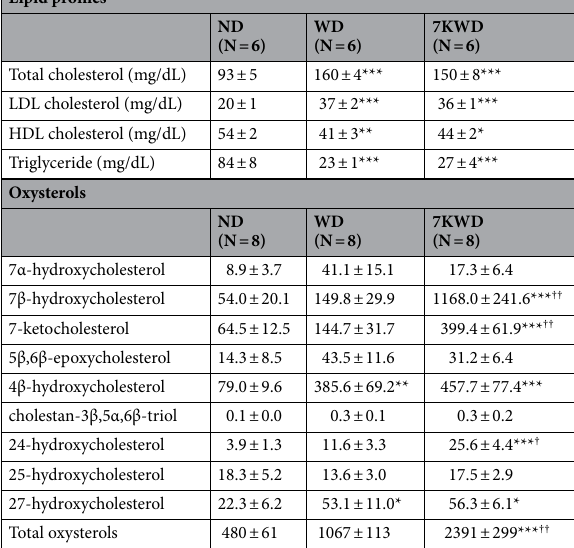
Table 1. Plasma lipid parameters. Cholesterol and triglyceride levels are shown in mg/dL. The level of each oxysterol component is shown in ng/mL. Data are expressed as the mean ± SEM and were compared using one- way ANOVA with the post hoc Tukey HSD test. *p < 0.05, **p < 0.01, and ***p < 0.001 versus the ND group. † p < 0.05, and †† p < 0.001 versus the WD group. ND, normal laboratory diet; WD, Western diet; 7KWD, WD containing